Question: What form of chart is displayed?
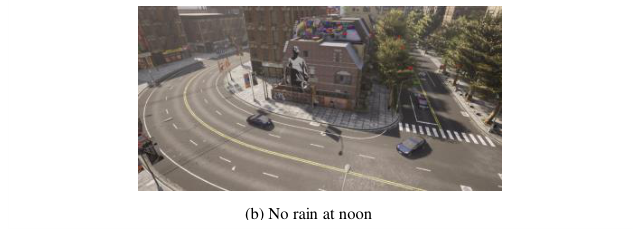
Answer: line